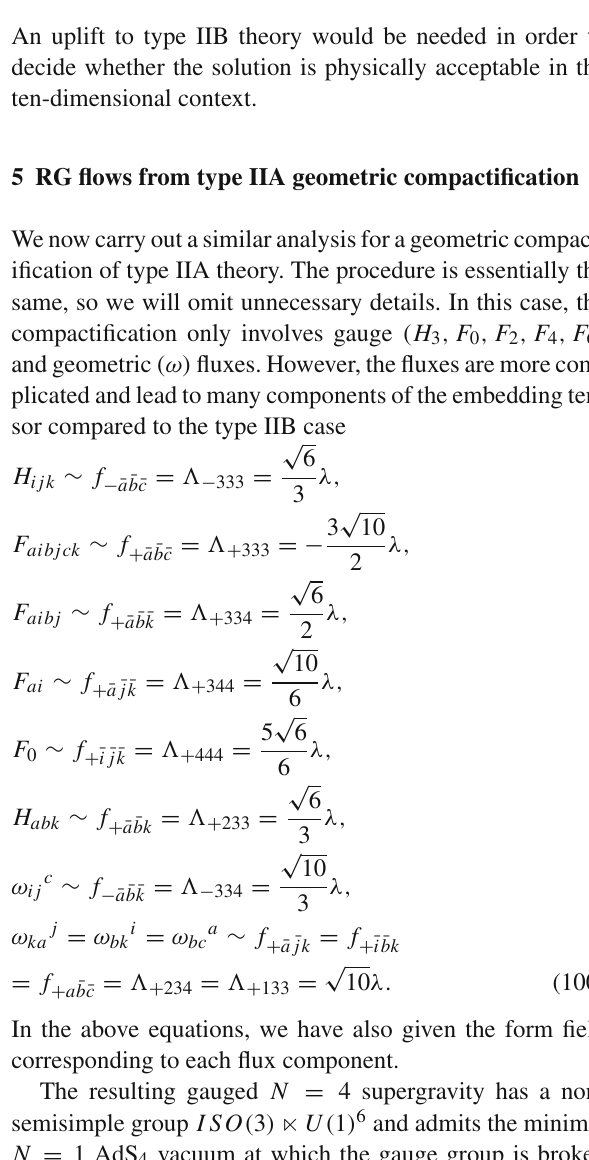
Fig. 3 N = 4 Janus solution from type IIB compactification within a truncation to ϕ g and χ g with κ = λ = 1 and (cid:21) = 2